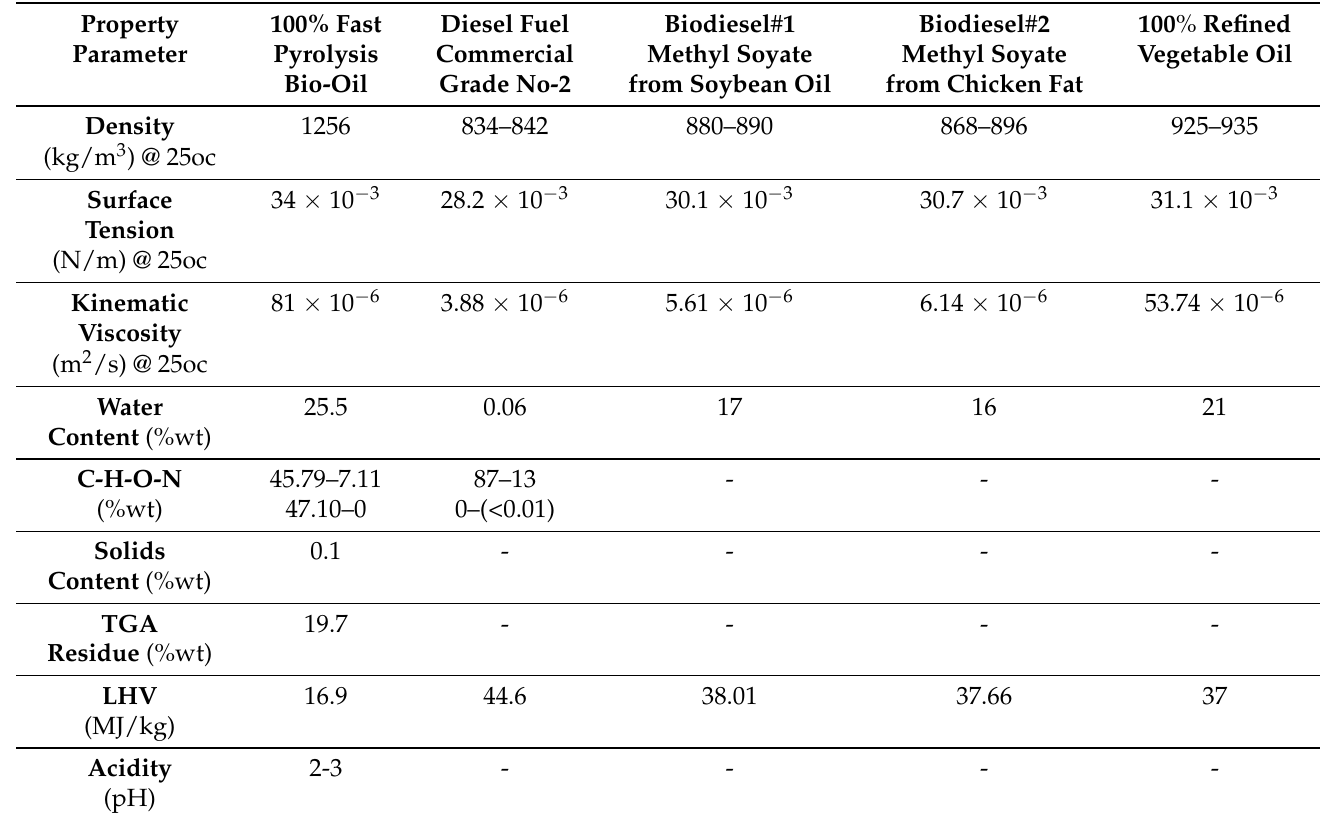
Table 2. Fuel property values for different fuels